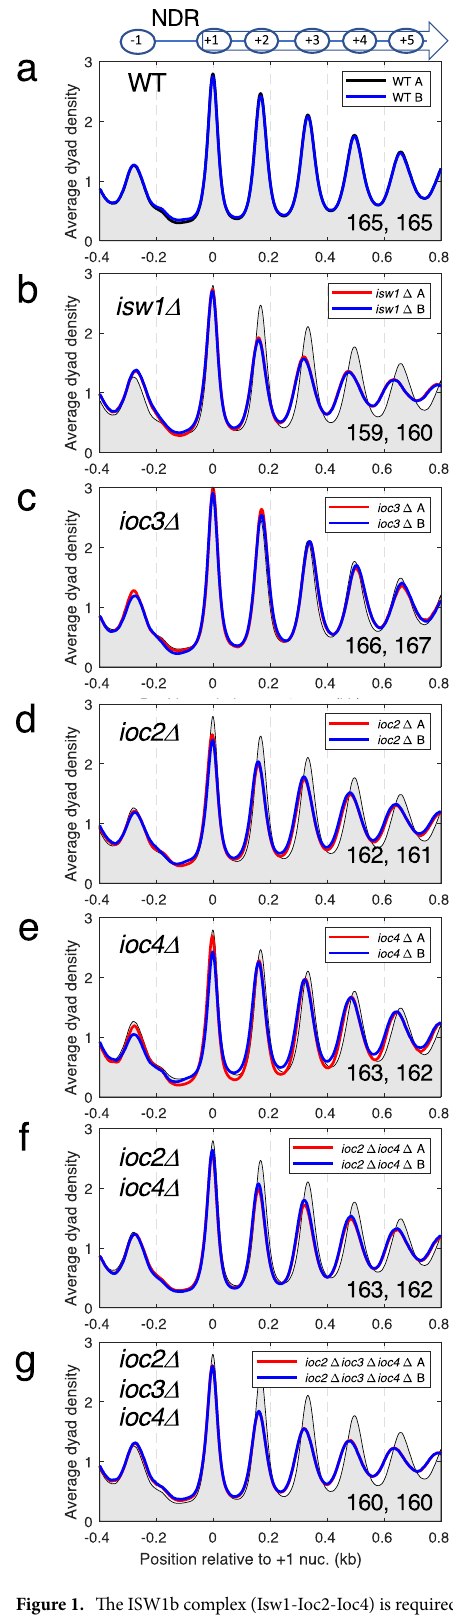
Figure 1. The ISW1b complex (Isw1-Ioc2-Ioc4) is required for setting wild type nucleosome spacing, whereas the ISW1a complex (Isw1-Ioc3) plays only a minor role. Average nucleosome dyad density plots for all genes: ( a ) wild type, ( b ) isw1∆ , ( c ) ioc3∆ , ( d ) ioc2∆ ,